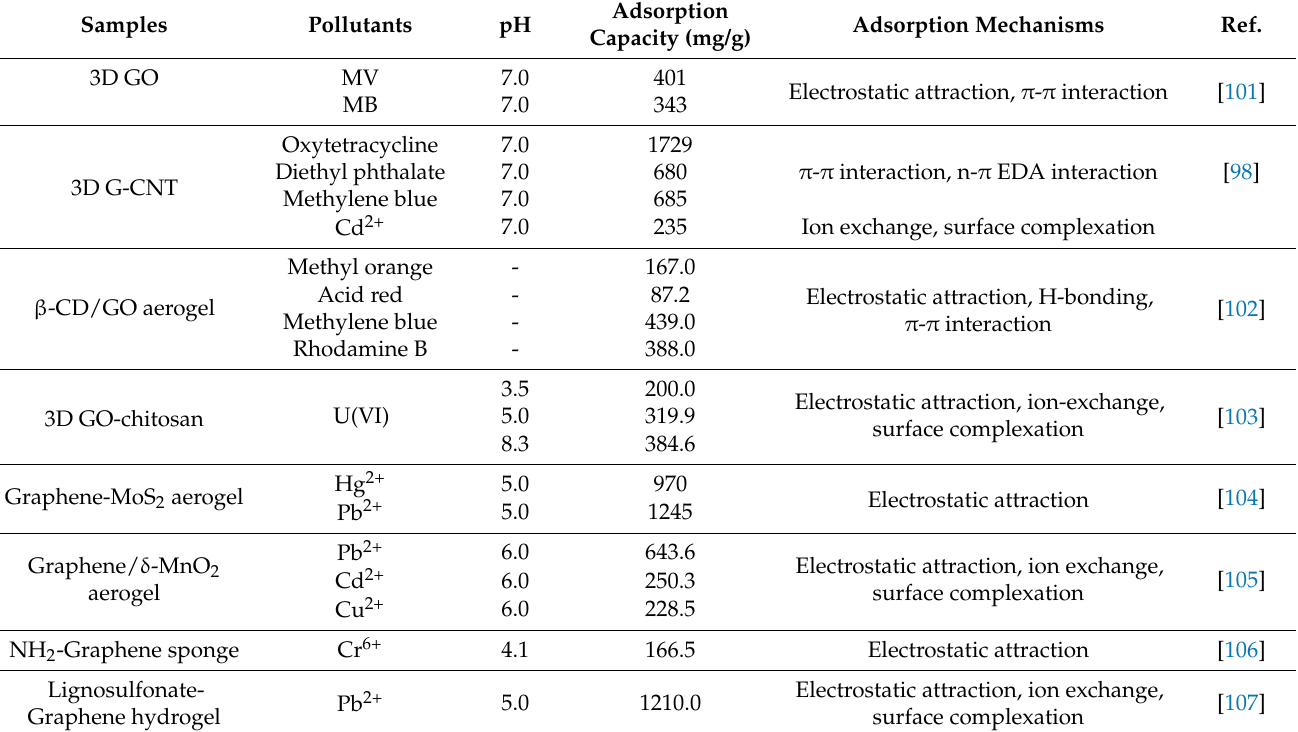
Table 2. A Summary of Adsorption Capacities and Mechanisms of Organic Pollutants and Heavy Metals onto 3D